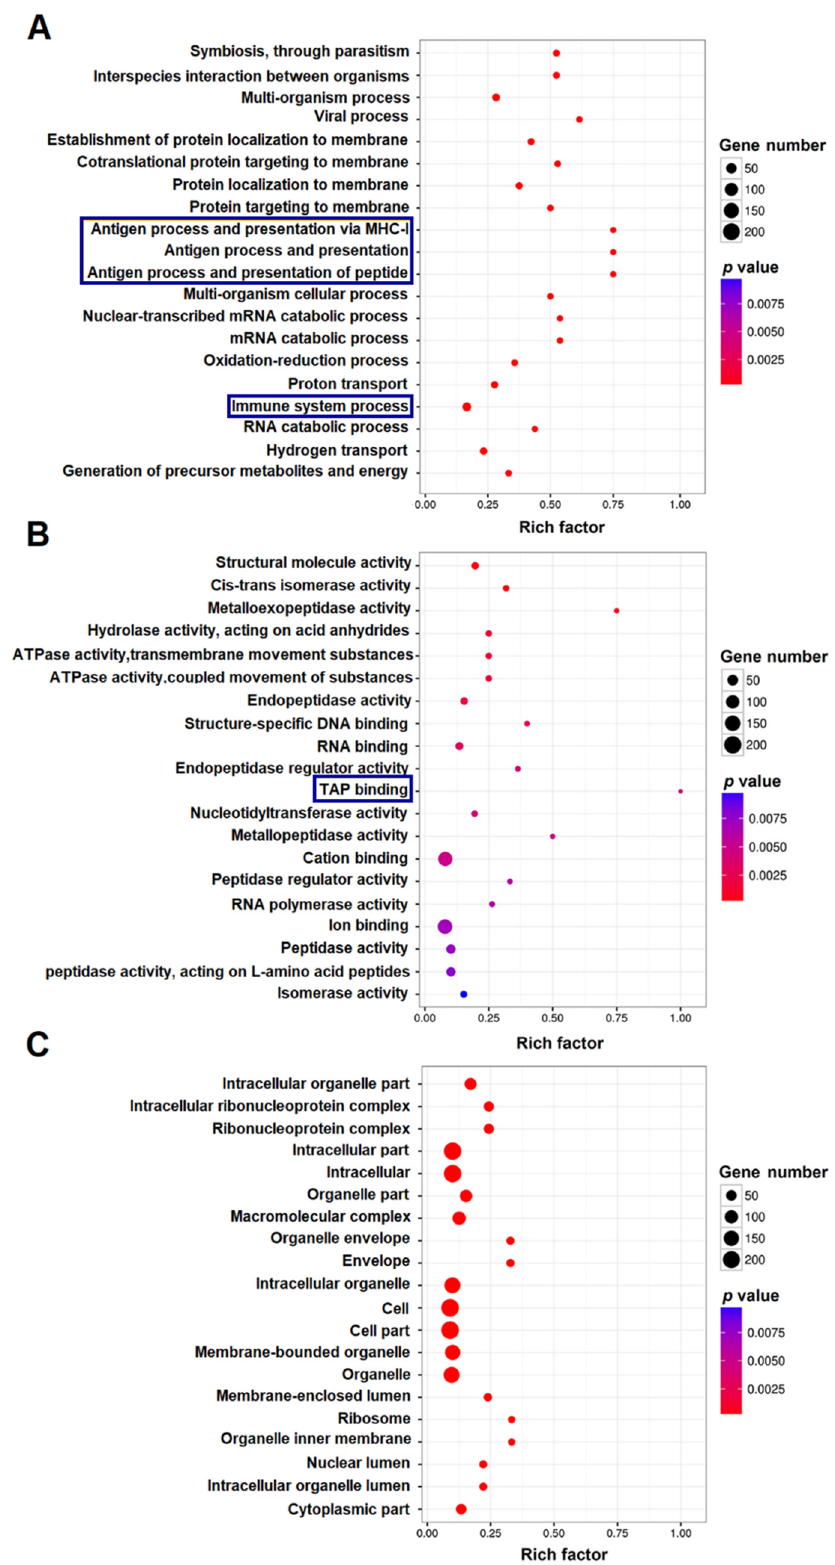
Figure 4. Gene Ontology (GO) enrichment analysis of differentially expressed genes (DEGs). Distribution of the top 20 (level-2) GO terms significantly enriched in the categories of biological process ( A ), molecular function ( B ), and cellular component ( C ) are shown. The immune related genes in ( A , B ) are boxed in blue.